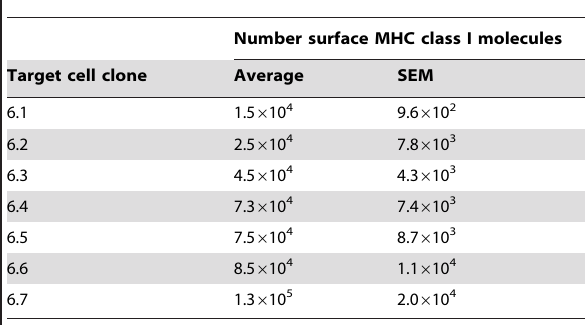
Table 1. Different target cell transfectants express varied levels of the MHC class I protein